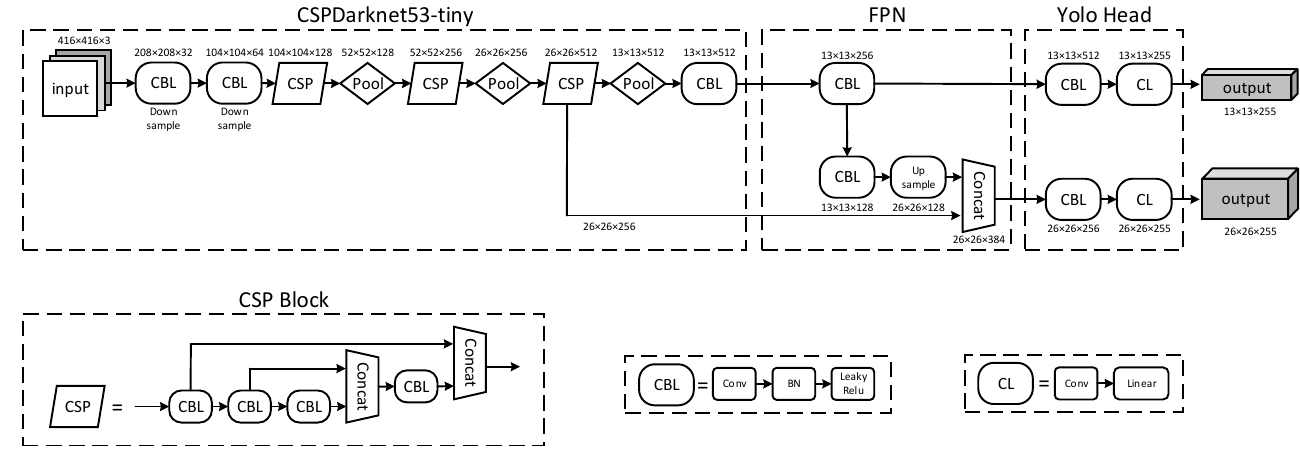
Figure 6. Detailed structure of YOLOv4-tiny.